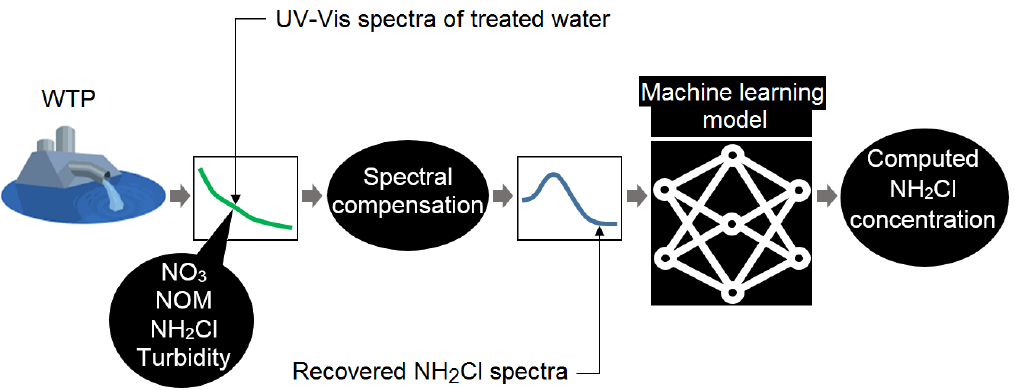
Figure 1. Schematic of the monochloramine detection method using UV-Vis spectra.